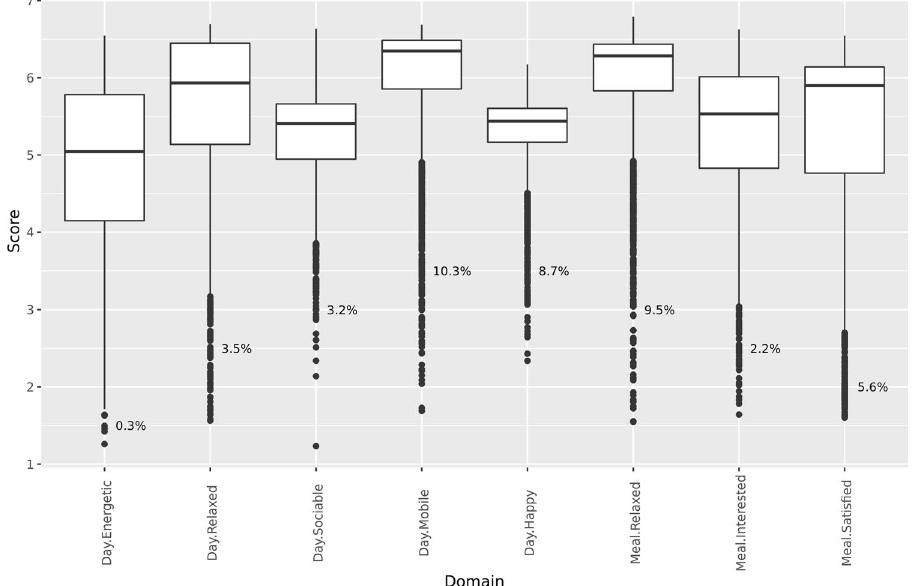
Figure 2. Domain score distribution for all surveyed dogs. Boxes delineate the 25th and 75th percentiles and show the median position in between. Whiskers indicate the range of all data excluding outliers and extreme values. The fraction of outliers and extreme values is represented explicitly as the dots representing these are